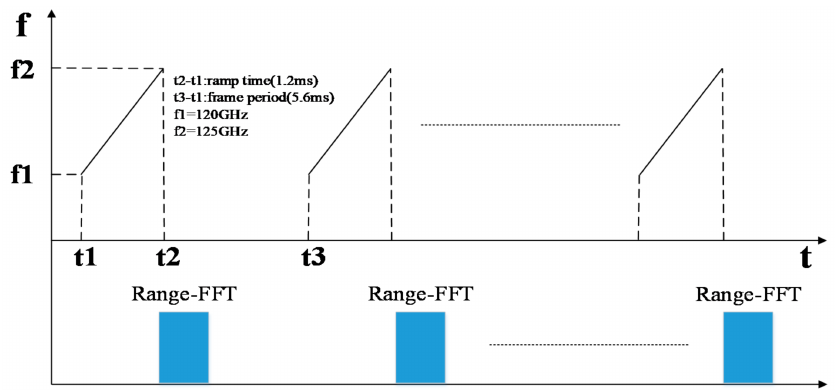
Figure 3. Chirp configuration of FMCW